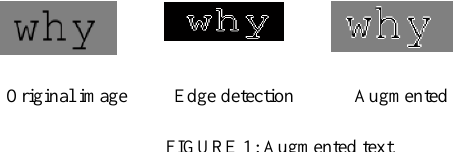
FIGURE 1: Augmented text